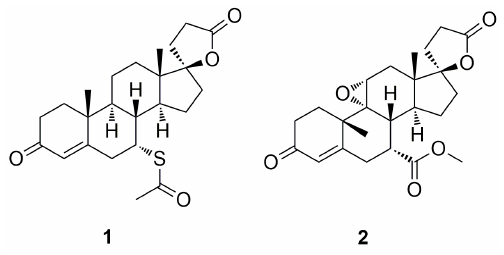
Figure 1. Chemical structures of the aldosterone receptor antagonists spironolactone (Aldactone ® , 1 ) and eplerenone (Inspra ® , 2 ).